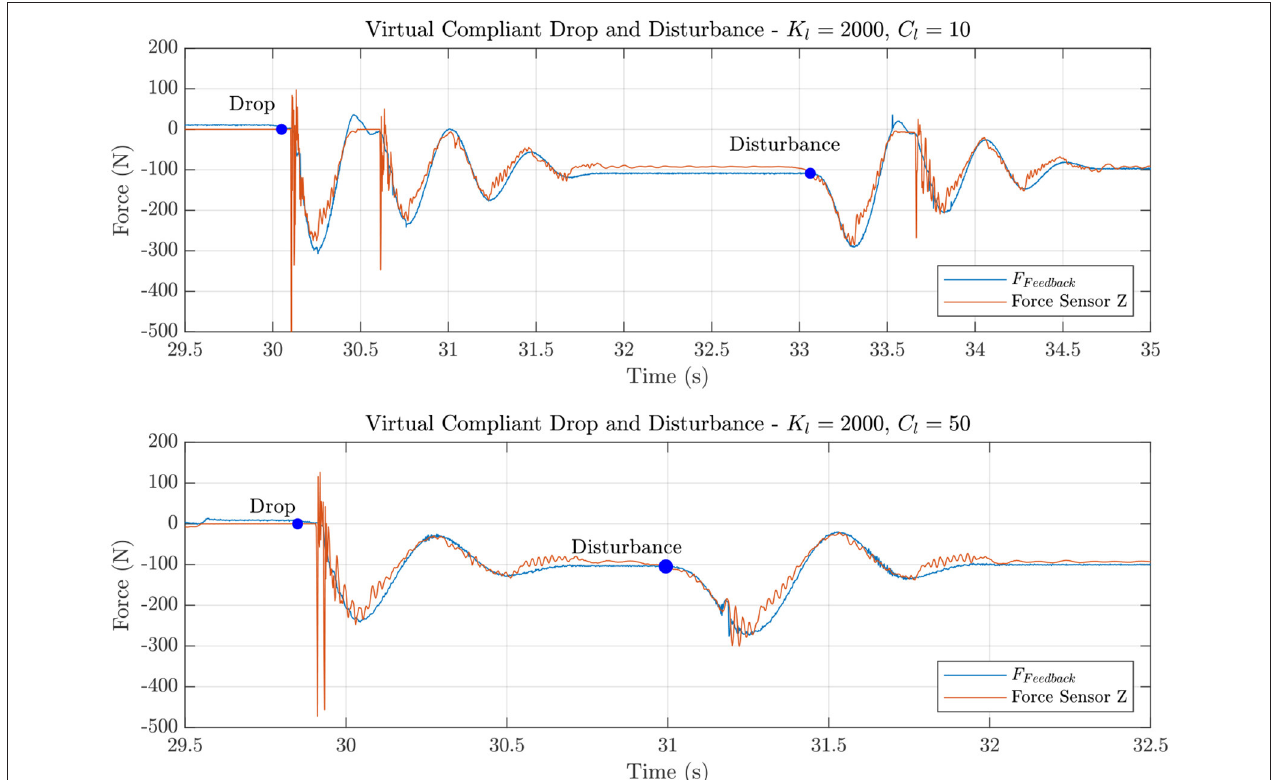
FIGURE 8 | These graphs show the single leg module undergoing virtual compliance testing where an external disturbance was applied and the platform was raised and dropped (each test seen by the blue marker). The purpose of this test was to identify the force transparency of the system by comparing the force calculated from the torque feedback (11) to the six-axis ATI force torque sensor